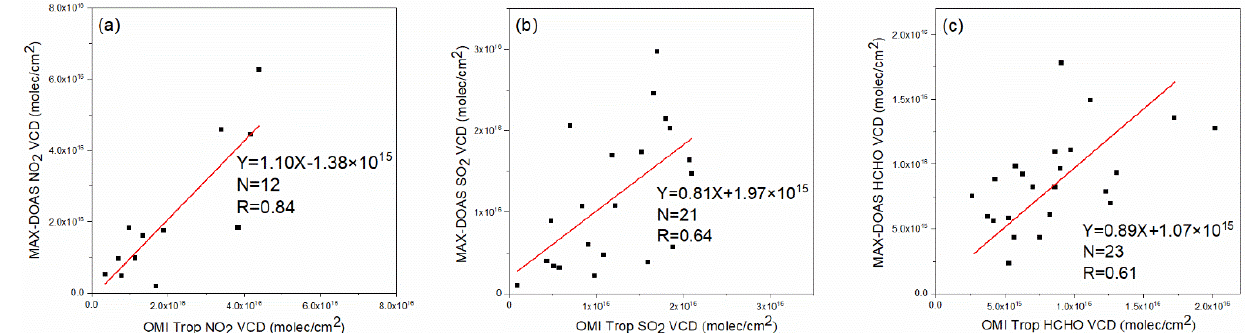
Figure 2. Correlation analysis between tropospheric VCDs measured by the in-situ MAX-DOAS and OMI satellite. ( a – c ) is NO 2 , SO 2 , and HCHO columns respectively.